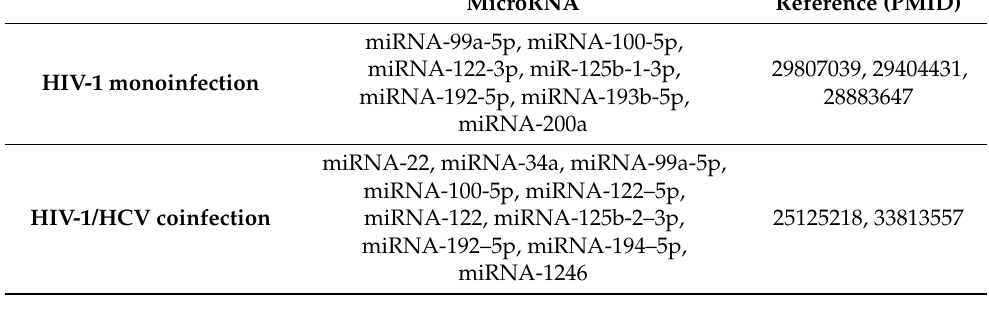
Table 2. Most relevant deregulated circulating microRNAs associated with liver injury in people living with HIV-1.